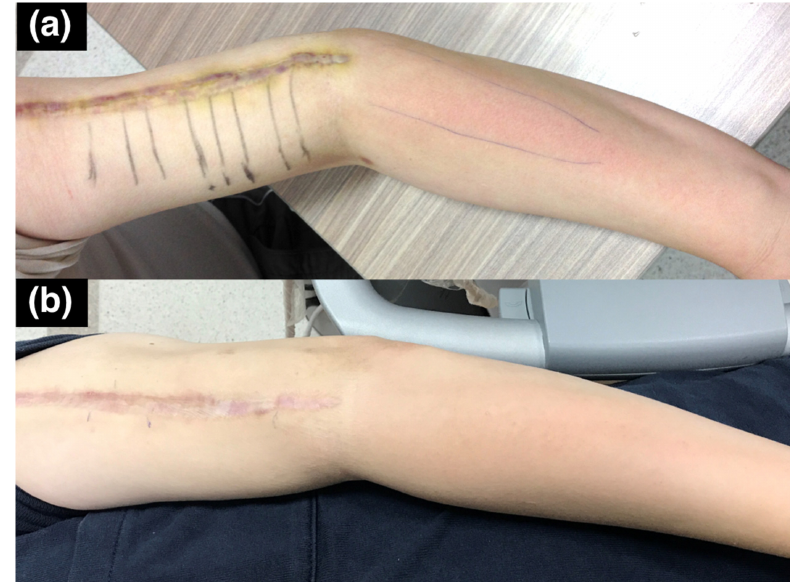
7 Figure 7. Case 2: Targets for hydrodissection. A 43-year-old man with radial nerve palsy after plating of a left humeral shaft fracture. ( a ) Before hydrodissection. Marks indicate the cross-sections with increased shear wave velocity during the shear wave elastography for injection. There is erythema over the innervation area of the posterior cutaneous nerve of the forearm. ( b ) After six hydrodissection sessions, the erythema improved and the allodynia